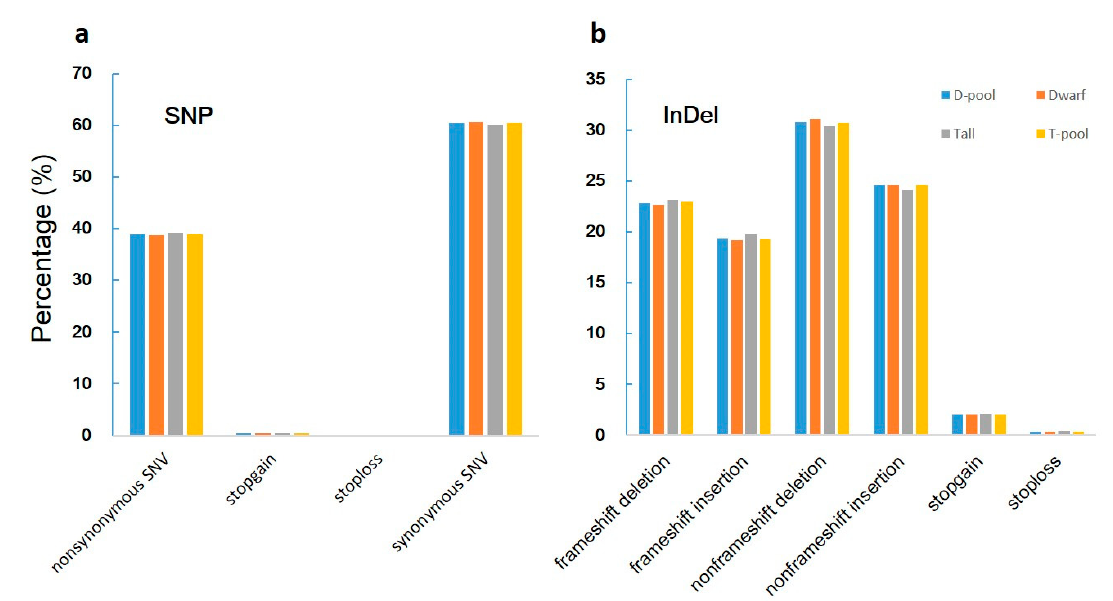
Figure 4. Percentage of SNPs and InDels with different function in each sample. Tall: tall parental G184-189; Dwarf: dwarf parental YA2016-12; T-pool: bulked DNA pool for extremely tall individuals from F 2 population; D-pool: bulked DNA pool for extremely dwarf individuals from F 2 population. Nonsynonymous single nucleotide variants (SNV): a single nucleotide change that cause an amino acid change; stopgain: a nonsynonymous SNV, frameshift insertion/deletion, nonframeshift insertion/deletion, or block substitution that leads to the immediate creation of a stop codon at the variant site. For frameshift mutations, the creation of a stop codon downstream of the variant is not counted as “stopgain”; stoploss: a nonsynonymous SNV, frameshift insertion/deletion, nonframeshift insertion/deletion, or block substitution that leads to the immediate elimination of a stop codon at the variant site; synonymous SNV: a single nucleotide change that does not cause an amino acid change; frameshift deletion: a deletion of one or more nucleotides that causes frameshift changes in a protein coding sequence; frameshift insertion: an insertion of one or more nucleotides that causes frameshift changes in a protein coding sequence; nonframeshift deletion: a deletion of three or multiples of three nucleotides that does not cause frameshift changes in a protein coding sequence; nonframeshift insertion: an insertion of three or multiples of three nucleotides that does not cause frameshift changes in a protein coding sequence;. ( a ): Percentage of SNP with different function in each sample; ( b ): Percentage of InDel with different function in each sample.